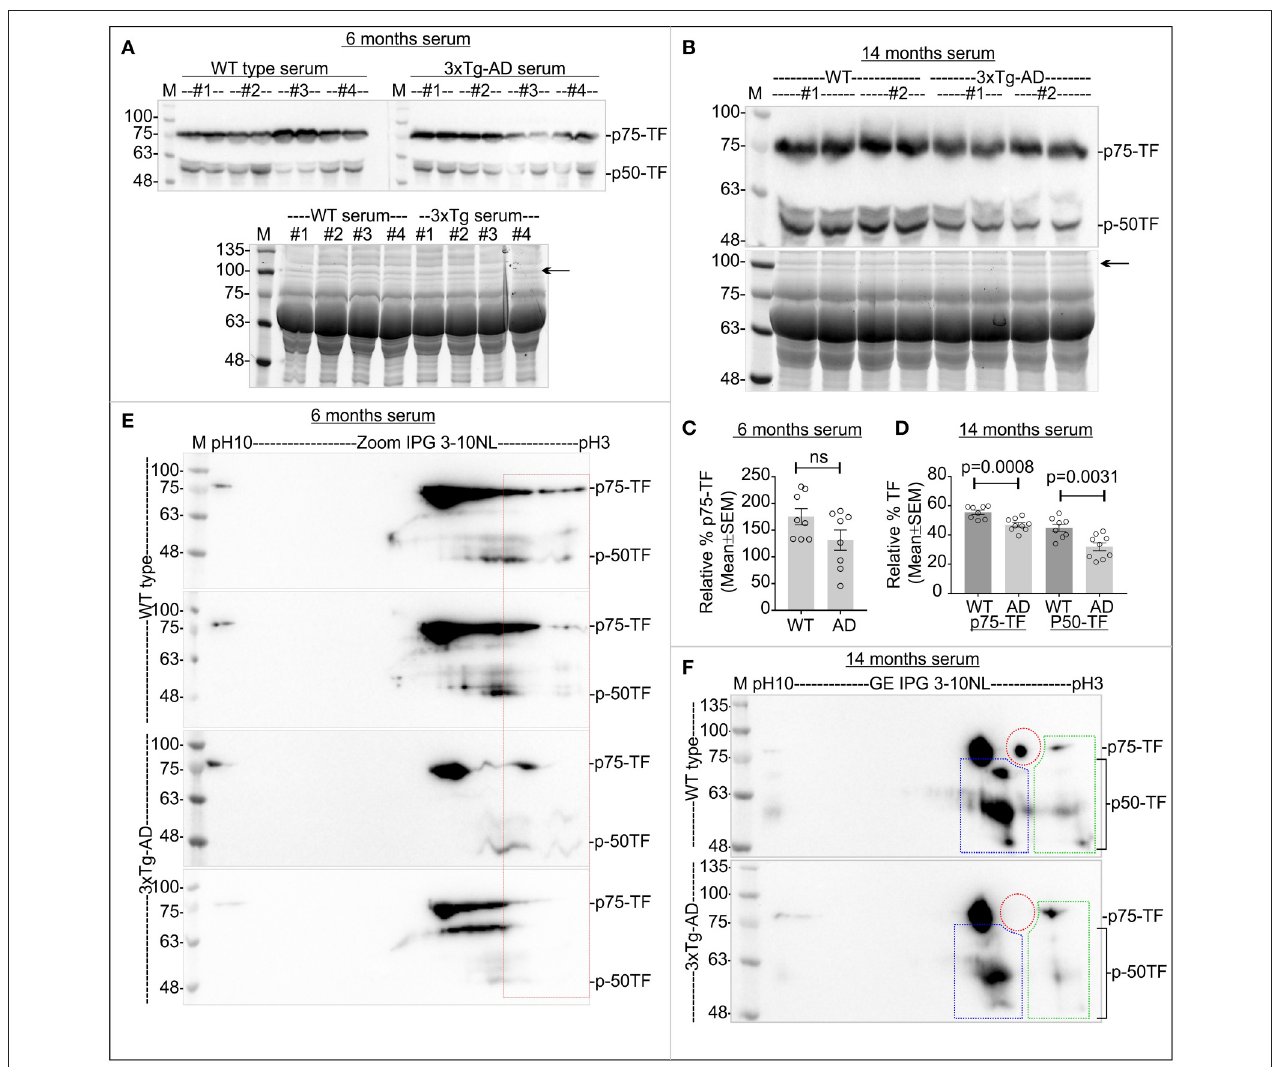
FIGURE 9 | Relative abundance of total TF and P-TF in the serum samples from early and late 3xTg-AD and age-matched control mice. (A,B) Top Panels: Immunoblots showing total TF level in the serum. Bottom panels: SDS-PAGE gel stained with Oriole to show total protein loading. Black arrows indicate the band used for normalization of total TF in the serum. (C,D) Scatter plot showing relative abundance of TF in the serum. N = 8 (2 replicates from 4 mice in each category. The p -value by t -test (unpaired). (E,F) Immunoblots showing charged fractions of TF. Red dotted area indicates P-TF (pH ∼ 3-4 fractions). Colored dotted rectangles in (F) indicate different charged fractions of the TF that also exhibited the marked difference between wild-type 3xTg-AD